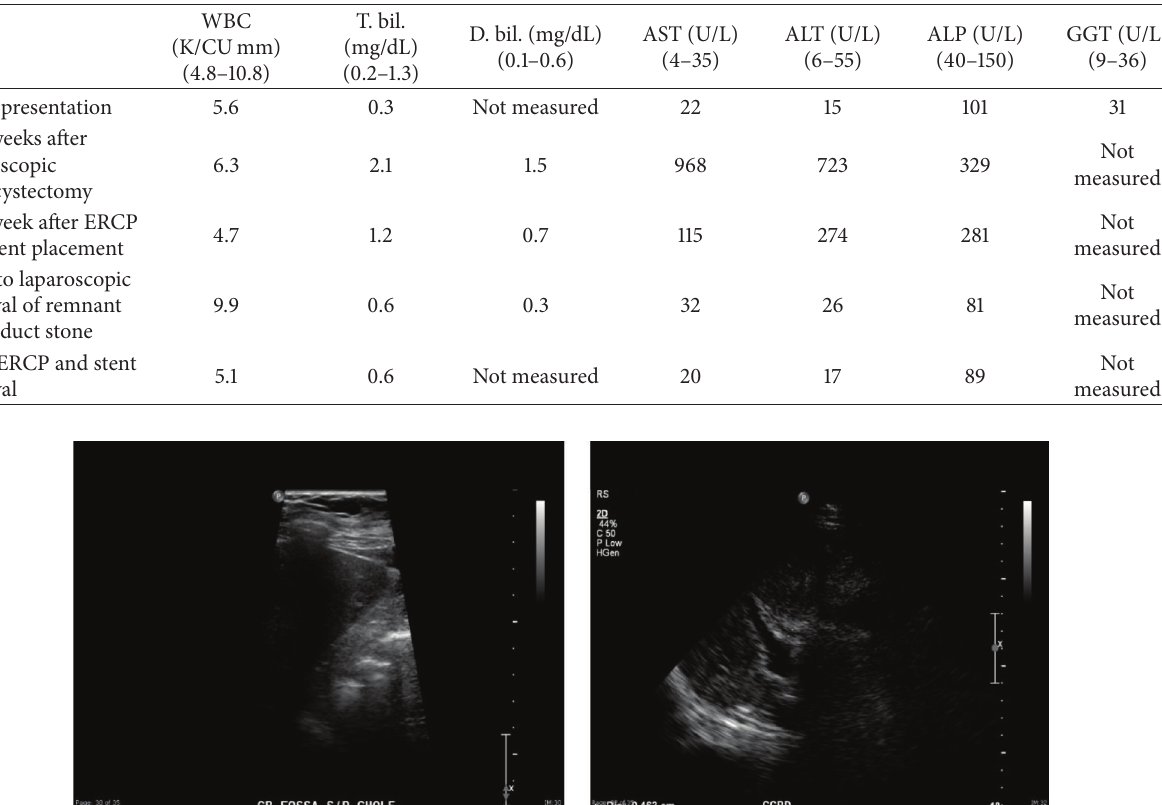
Table 1: Laboratory profile during patient course.